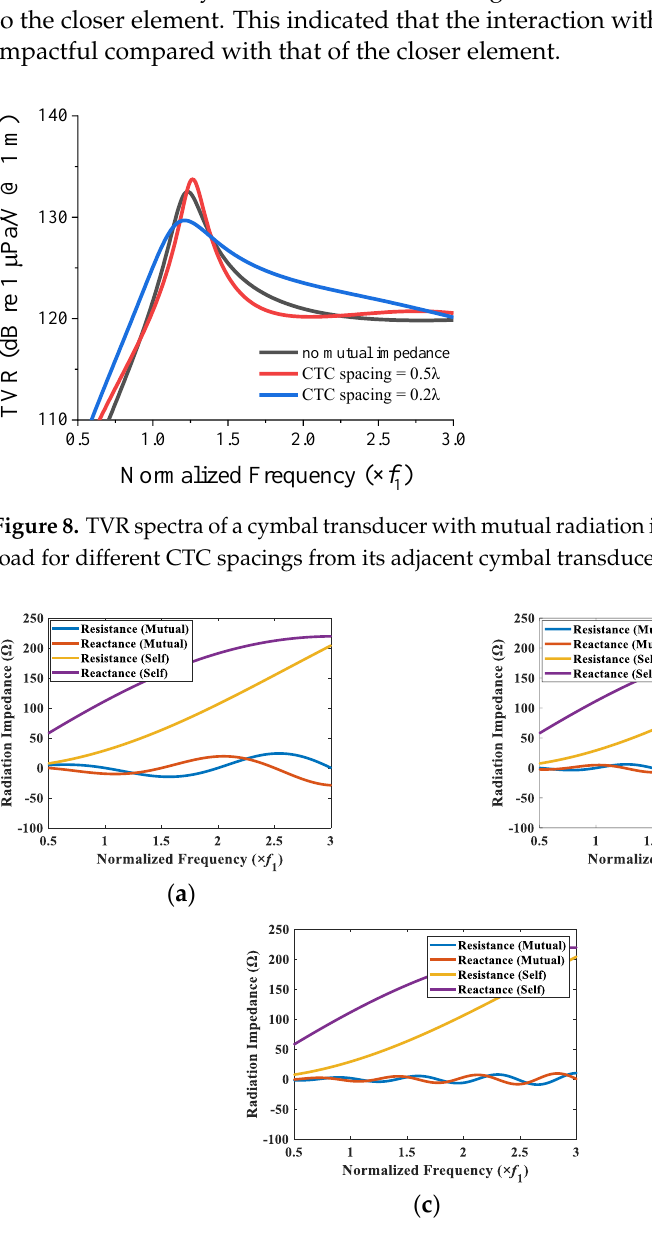
Figure 9. Self- and mutual radiation impedance of element 1 with its neighboring elements (CTC spacing of 0.5 𝜆 ): ( a ) elements 1 and 2; ( b ) elements 1 and 7; ( c ) elements 1 and 9.